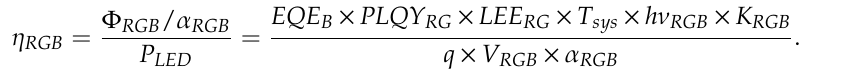
Figure 9. The required luminance of color-conversion micro-LED display as a function of aperture ratio for achieving the listed ACR under three ambient light illuminances: ( a ) 2000 lux, ( b ) 450 lux and ( c ) 200 lux.